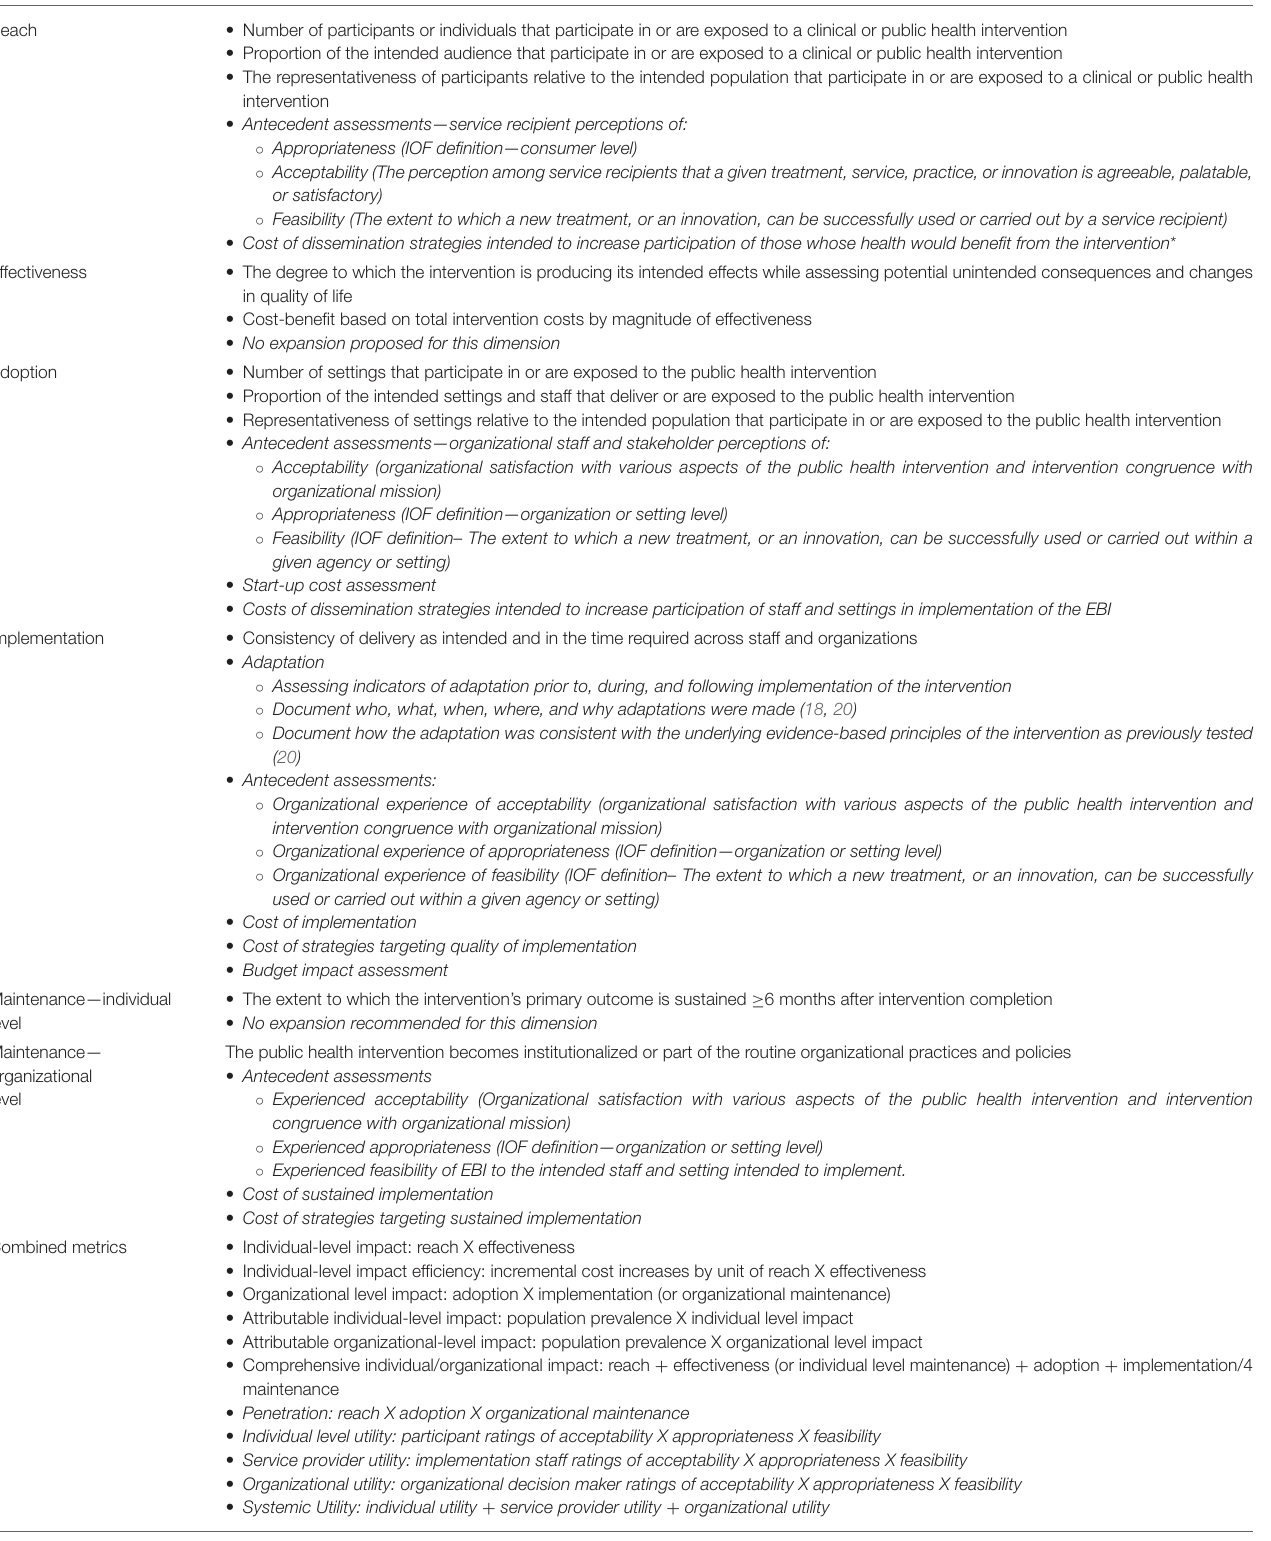
TABLE 3 | Expanded operationalization of RE-AIM.